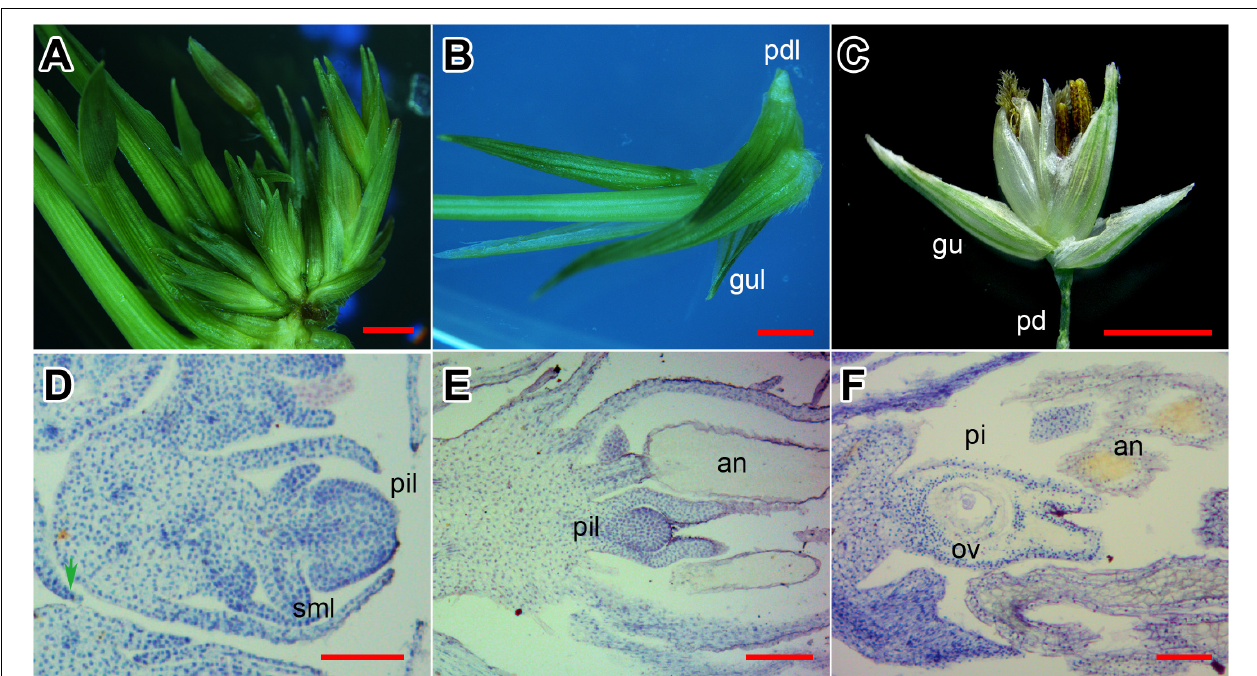
FIGURE 1 | Evidence of flower reversion in switchgrass. (A) Reversed shoots and unreversed florets. (B) Single reversed shoot separated. (C) A normal floret from switchgrass plant. (D) Longitudinal section of a reversed shoot. (E) Longitudinal section of a half-reversed floret. (F) Longitudinal section of an unreversed floret. Pd, pedicel; pdl, pedicel-like; gu, glume; gul, glume-like; pi, pistil; pil, pistil-like; sml, stamen-like; an, anther; st, style; ov, ovule. (A–C) Bar = 2 mm; (D,E) bar = 0.5